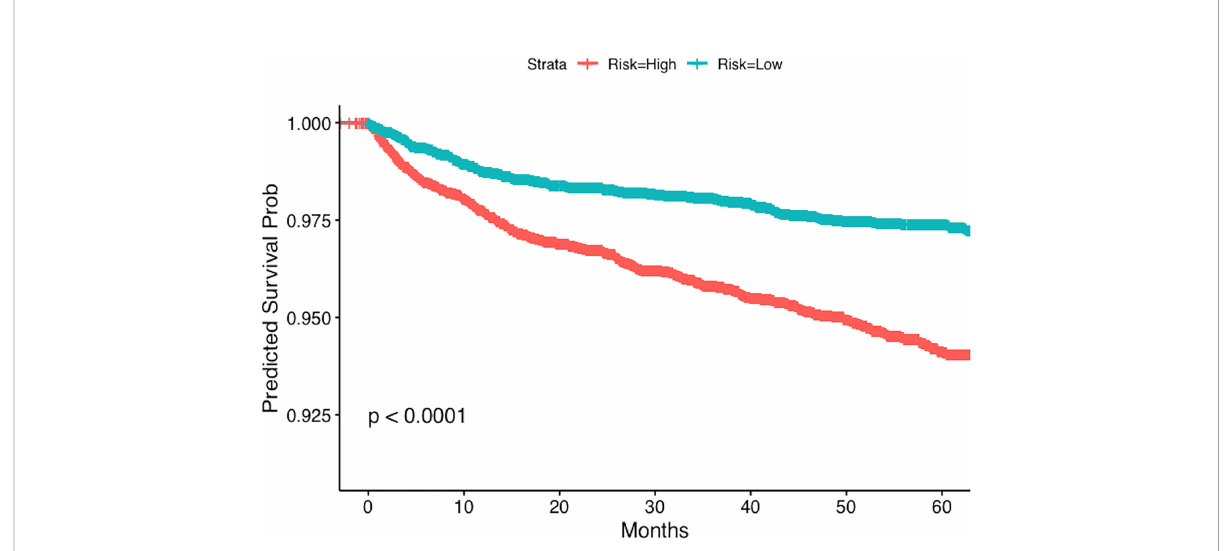
FIGURE 2 Kaplan-Meier plot for the time to DVT from the time of diagnosis of GCA strati fi ed by predicted risk (blue and red lines)